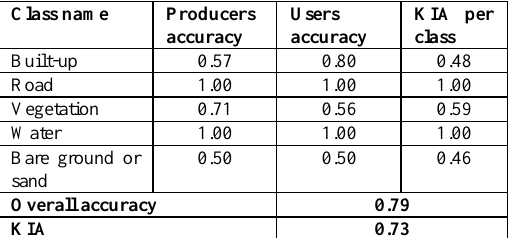
Figure 5b: Image segmentation (Level 1, scale: 50)